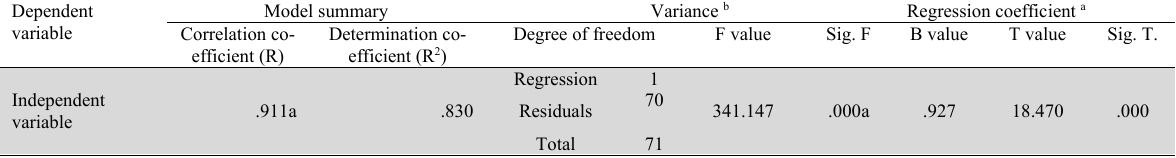
The results of the simple regression analysis for testing the first sub-hypothesis